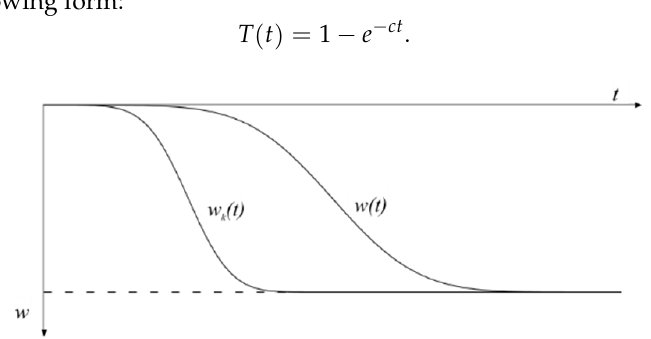
Figure 6. Distribution of steady w k ( t ) and dynamic w ( t ) subsidence